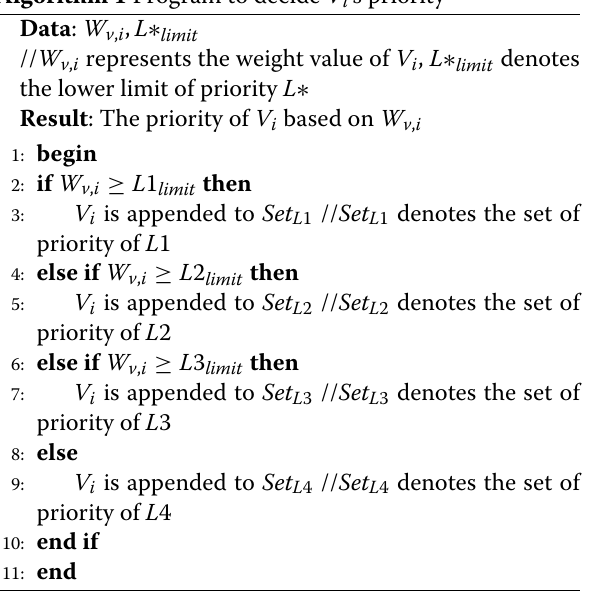
Algorithm 1 Program to decide V i ’s priority